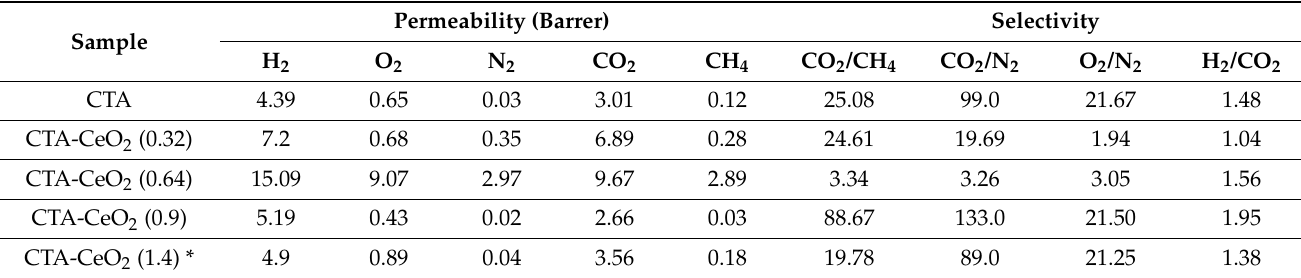
Table 3. Permeability of the synthesized MMMs and their respective selectivity for gases at a temperature of 25 ◦ C and pressure of 1 torr.